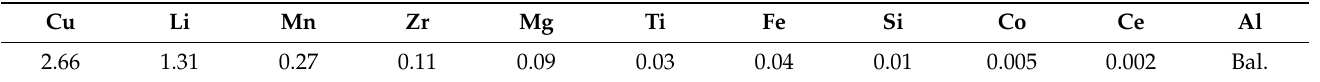
Table 1. Chemical composition of the investigated aluminum alloy